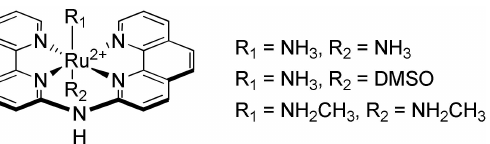
Figure 24. Structure of the complexes using the constrained bpa ligand studied by Shao et al.